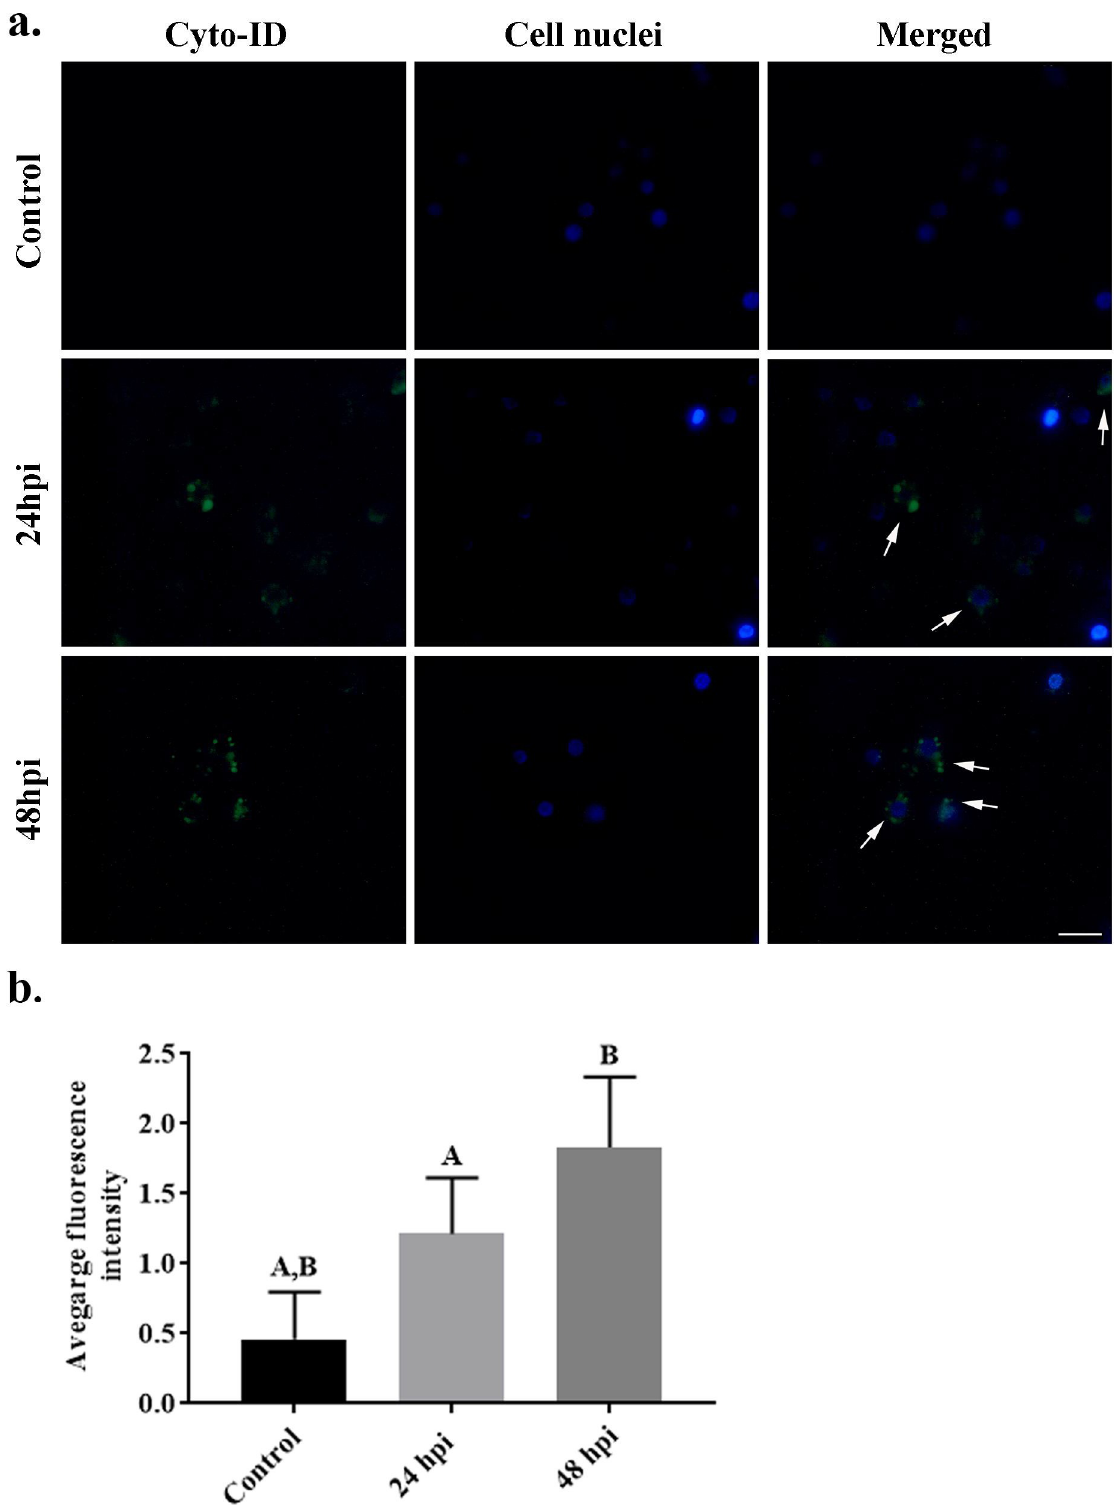
Fig 7. Hemocytes of Galleria mellonella control larvae, 24 hours post infection and 48 hours post infection with the entomopathogenic fungus Conidiobolus coronatus . (a) The intensity of LC3 protein was evaluated by LC3 antibody staining and (b) their average fluorescence intensity was quantified. Blue color–nuclei labelled by DAPI (Ex/Em: 345/455 nm); Red/orange color–actin fibers labelled with ActinRed 555 kit reagent (Ex/Em: 540/565 nm); Green color–LC3 protein. Scale bar 10 μ m. https://doi.org/10.1371/journal.pone.0228407.g007 PLOS ONE | https://doi.org/10.1371/journal.pone.0228407 February 3,